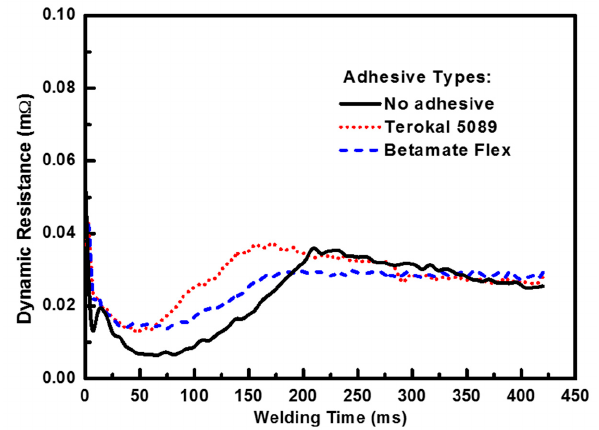
Figure 10. Effect of the adhesive types on the dynamic resistance during the welding process.